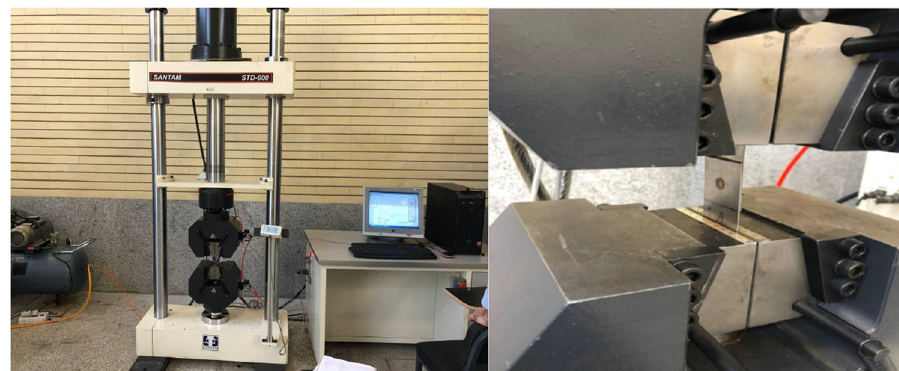
Figure 10: Tensile shear test.